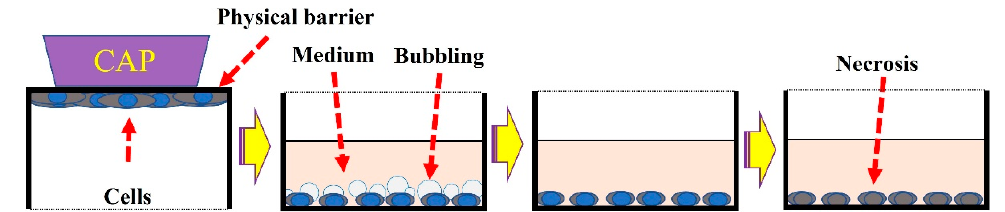
Figure 4. Schematic illustration of a physical-based CAP treatment in vitro. Here, the feature of necrosis is used to represent the cell death pathway observed in references. Quick bubbling and cytosolic shrinkage are two key features of physical-based cell death.